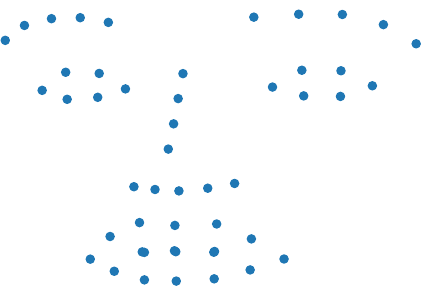
Figure 2. The selected 49 facial landmarks extracted from the RGB facial